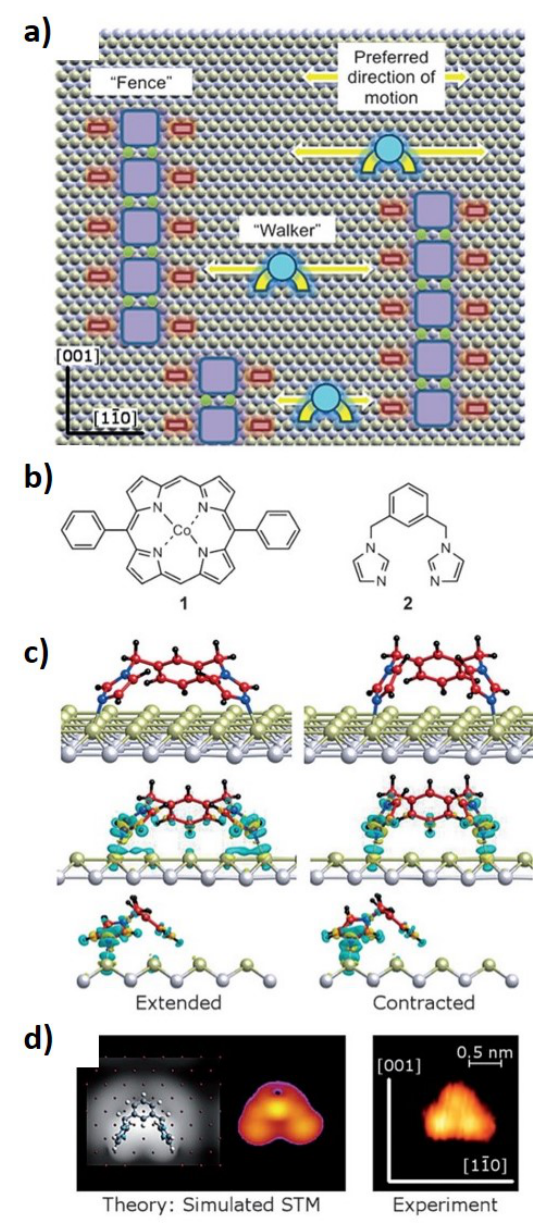
Figure 8. ( a ) Schematic representation of a walking molecule—a walker—which moves between two immobilized fences. The walker is a divalent bis(imidazolyl) molecule and the fence is a cobalt porphyrin represented in ( b ). The walker moves by attachment and detachment cycles between two fences, as represented by DFT simulations in ( c ), and the respective experimental STM image ( d ). (Reprinted with permission from reference [73]. Copyright 2015 WILEY-VCH Verlag GmbH & Co. KGaA,